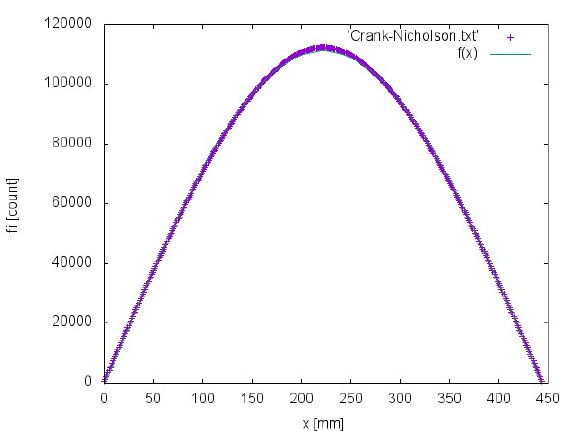
Figure 1. Accuracy of Crank-Nicholson method.